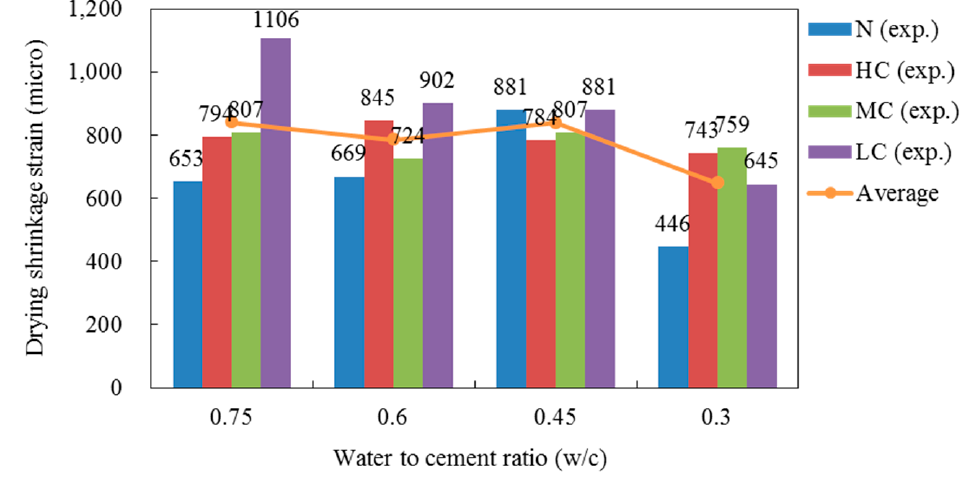
Figure 12. Ultimate drying shrinkage strain of concrete with different water-to-cement ratios.